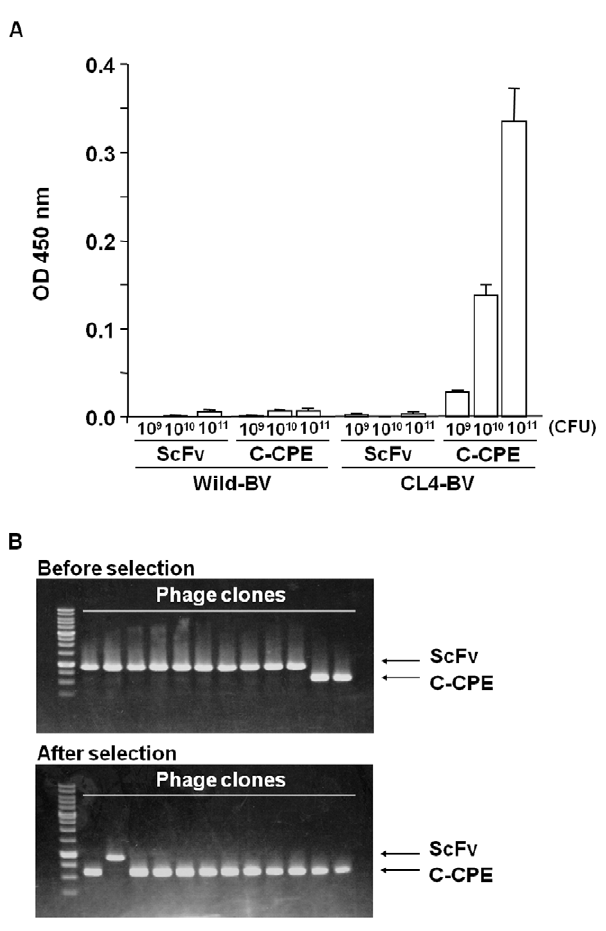
Figure 2. Selection of C-CPE-displaying phage by using the CL4-BV system. A) Interaction of C-CPE-displaying phage with CL4-BV. Wild-BV or CL4-BV was coated on an immunoplate, and then scFv- displaying phage or C-CPE-displaying phage was added to the BV- coated immunoplate at the indicated concentrations. The BV-bound phages were detected by ELISA with anti-M13 antibody as described in Materials and methods. Data are representative of two independent experiments. Data are means 6 SD (n=3). B) Enrichment of C-CPE- displaying phage by the BV system. A mixture of scFv-phage and C-CPE- phage (mixing ratio of scFv-phage to C-CPE-phage =2:10) was incubated with a CL4-BV-coated immunotube, and the bound phages were recovered. Each phage clone was identified by PCR amplification, followed by agarose gel electrophoresis. Upper and lower pictures are before and after the selection, respectively. The putative sizes of the PCR products are 856 and 523 bp in scFv and C-CPE, respectively. The data are representative of two independent experiments.